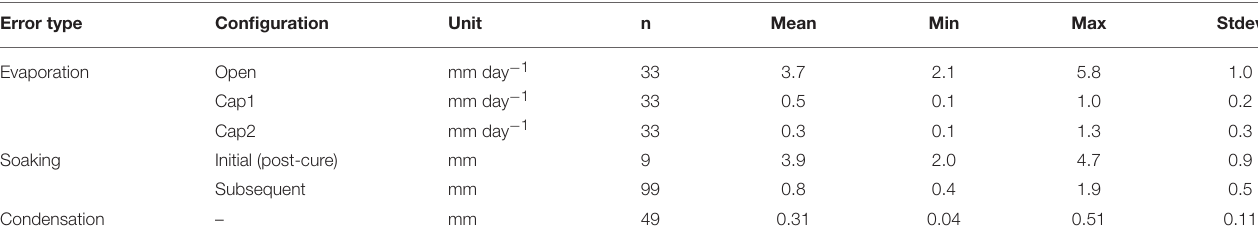
TABLE 1 | Summary of the results from the evaporation, soaking, and condensation experiments (error type), including configuration, unit, sample size ( n ), mean, minimum (min), maximum (max), and standard deviation (stdev). Error type